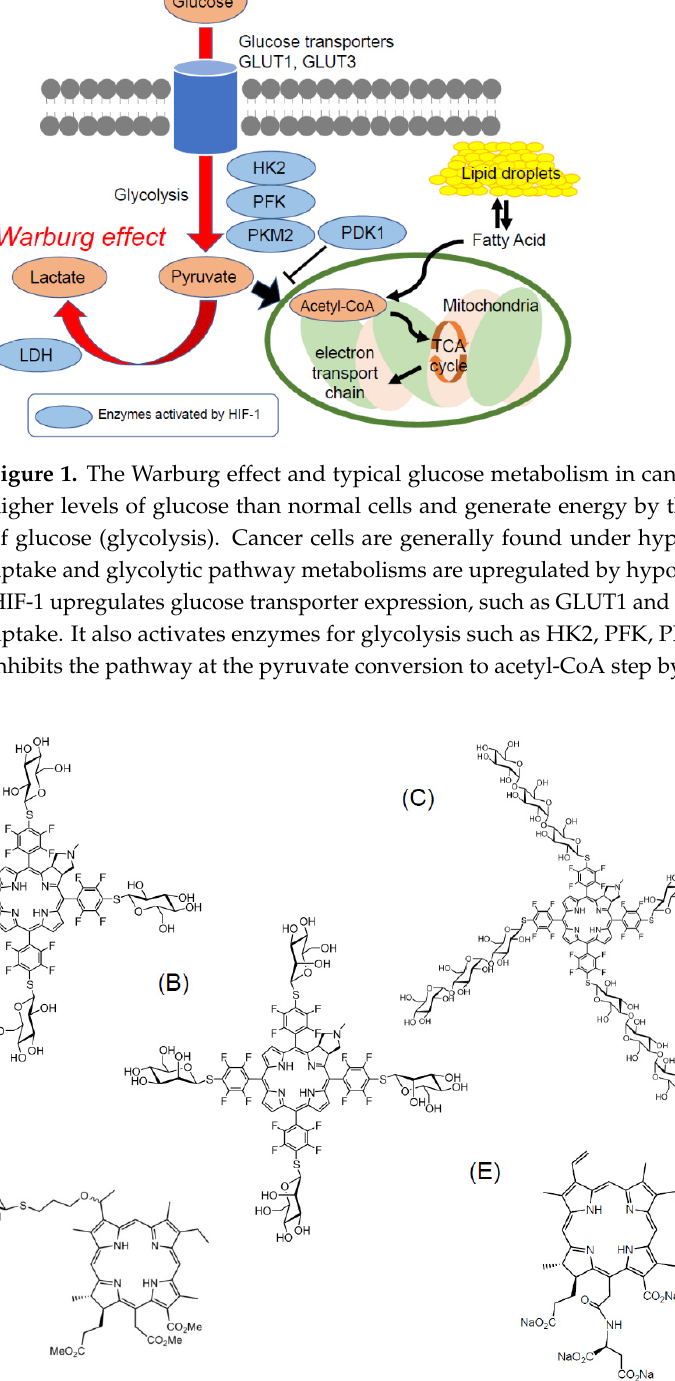
Figure 2. The molecular structure of sugar-conjugated chlorins. ( A ) Glucose-conjugated chlorin (G-chlorin), ( B ) mannose- conjugated chlorin (M-chlorin), ( C ) maltotriose-conjugated chlorin (Mal 3 -chlorin), ( D ) glucose-conjugated chlorin e6 (SC- N003HP), and ( E ) talaporfin sodium. Talaporfin sodium is now clinically used as a second-generation photosensitizer (PS) in Japan.